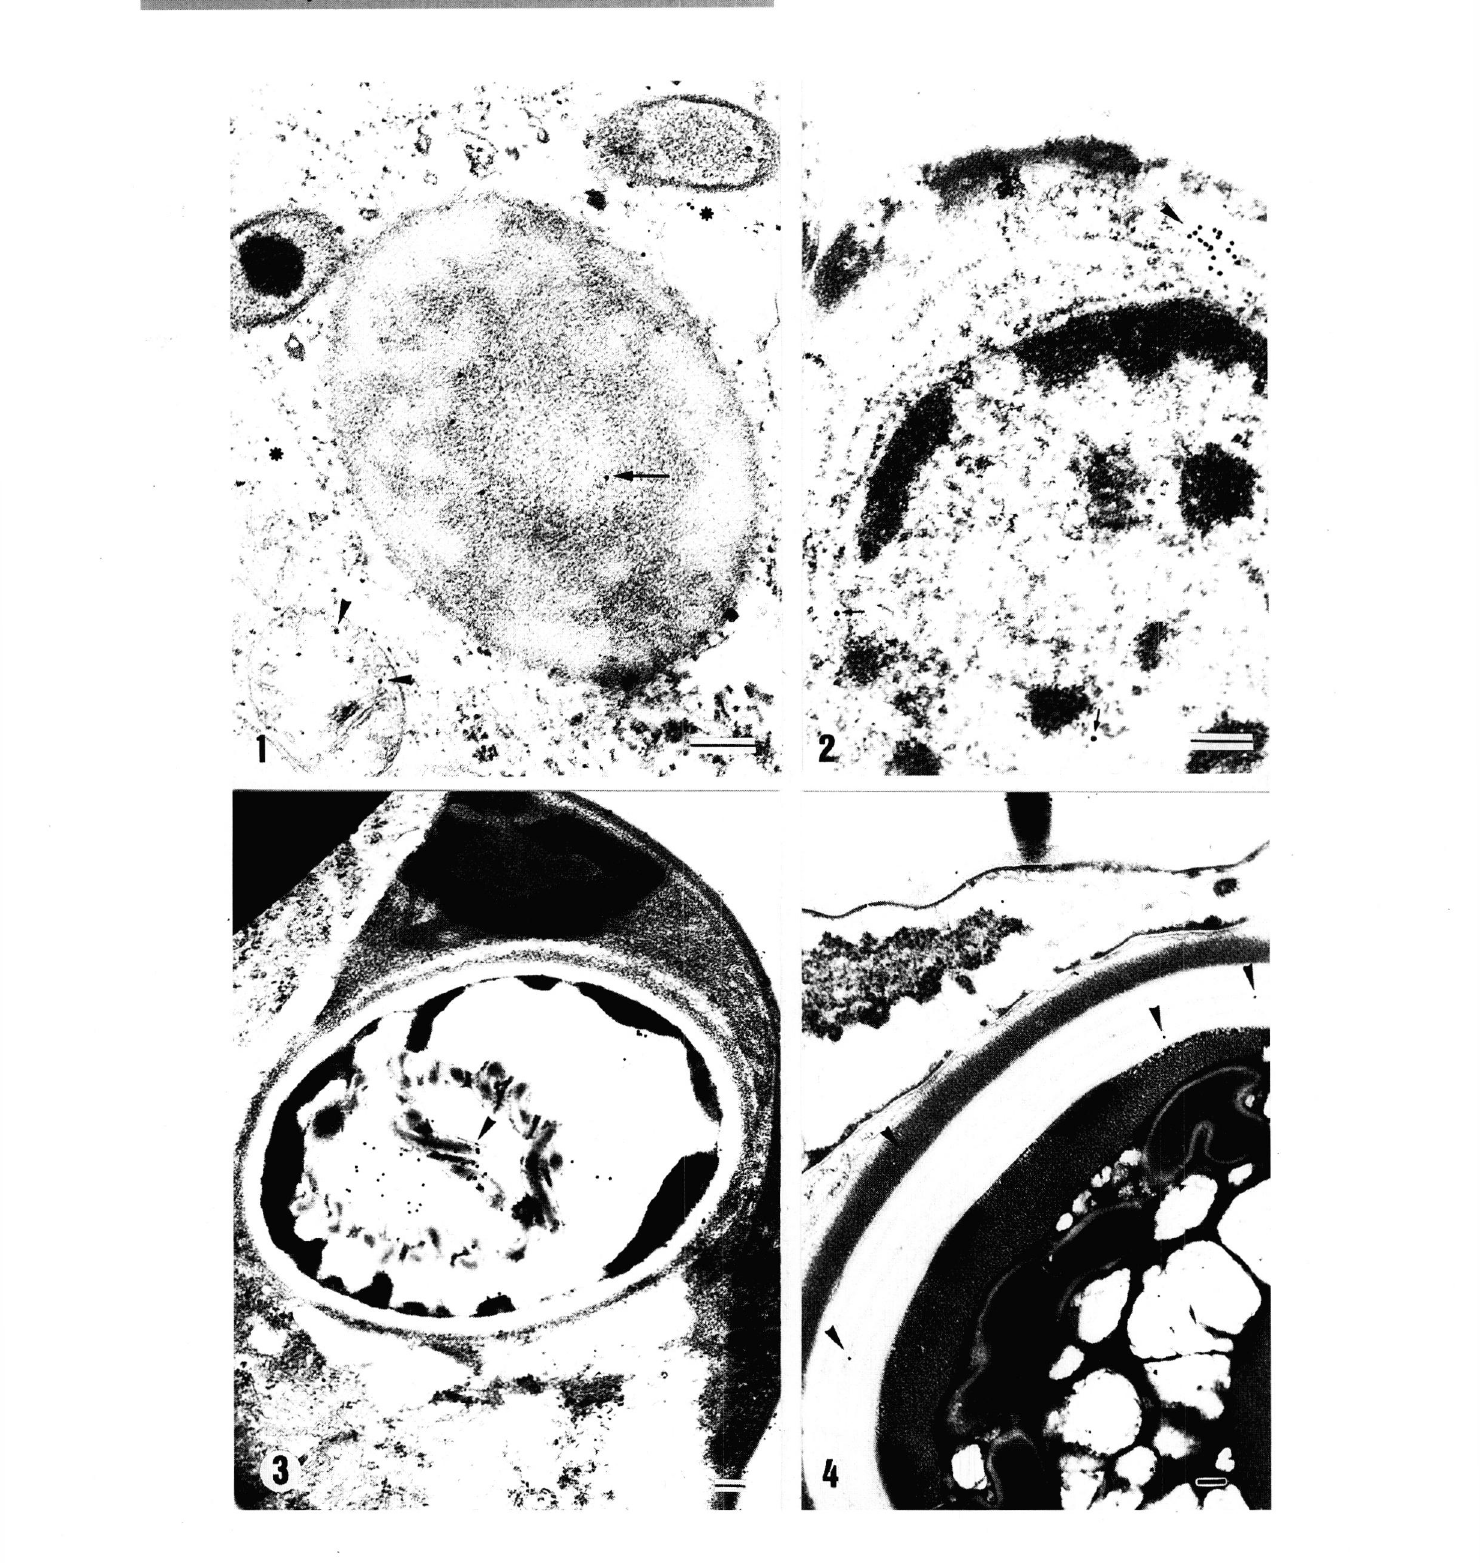
Figs. 1 to 4. - Transmission electron microscopy images of myxosporean parasites in tissue sections stained with lec tins. Figs. 1 to 3- Leptotheca sp. from common dentex trunk kidney. Figs. 1, 2. Sections of immature spores stained with Con-A. Fig. 1. - Note the labelling in mitochondria (arrowheads), in the cytoplasm (*), in the capsular primordium (arrow) and in the external tube. Fig. 2. - Note the scarce labelling in the nucleus of a capsulogenic cell (arrows) and a group of gold particles associated to rough endoplasmic reticulum (arrowhead). Fig. 3. - Section of a mature spore stained with BS-I. A distinct labelling in the polar filament is observed (arrowhead). Fig. 4. - Polysporoplasma sparis in gilthead sea bream trunk kidney stained with Con-A. Note the staining of the polar capsule wall (arrowheads) and valves. Bars = 0.2 µm. 188 Mémoire